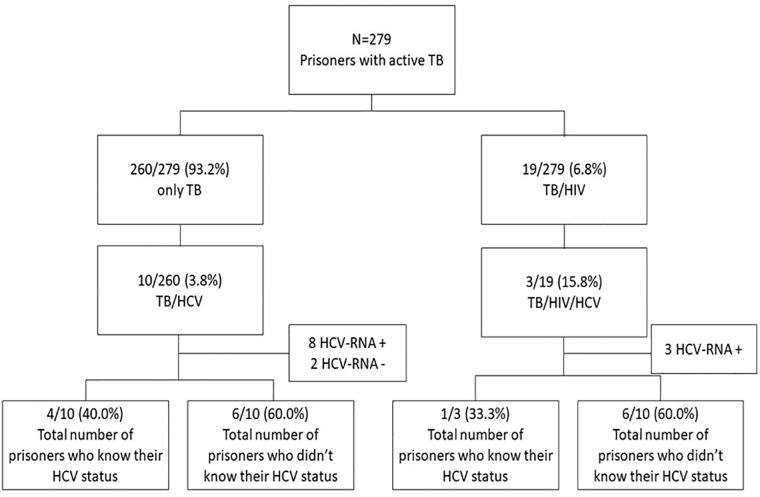
Enrollment of bacteriologically confirmed TB cases in the study.